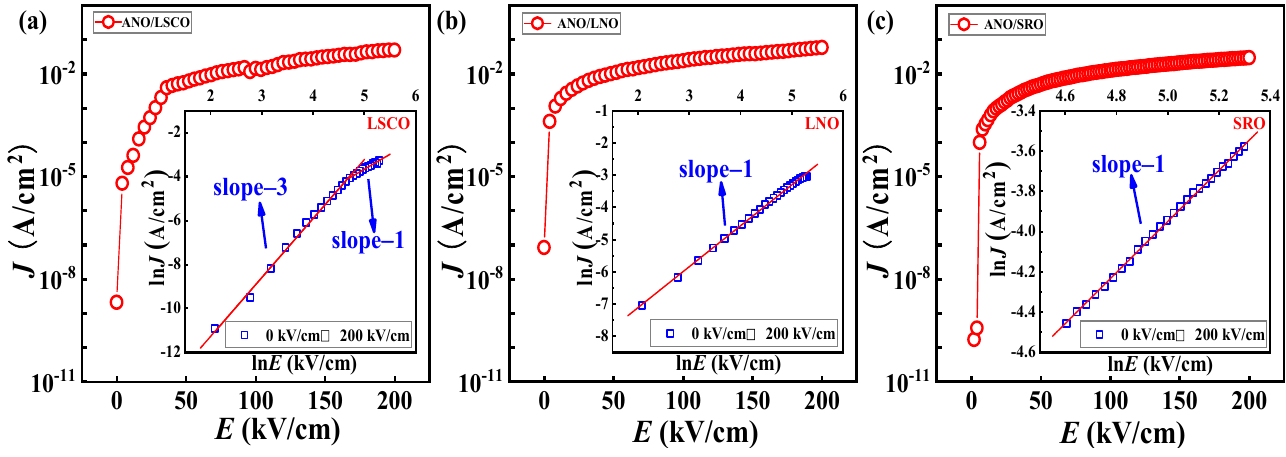
Figure 4. Leakage current density of ANO films grown on LSCO ( a ), LNO ( b ) and SRO ( c ) bottom electrodes. The insets show the conductive mechanisms of ANO films corresponding to ( a – c ). The P - E loops of ANO films grown on LSCO, LNO and SRO bottom electrodes are shown in Figure 5. The applied electric fields are set to be 200 kV/cm, 300 kV/cm and 400 kV/cm. It can be seen that ANO film grown on LSCO bottom electrode shows linear P - E loops at 200–300 kV/cm and double P - E loops at 400 kV/cm. When ANO films are grown on LNO and SRO, bottom electrodes show slim P - E loops at 200 kV/cm and double P - E loops at 300–400 kV/cm. These results indicate that all ANO films are of